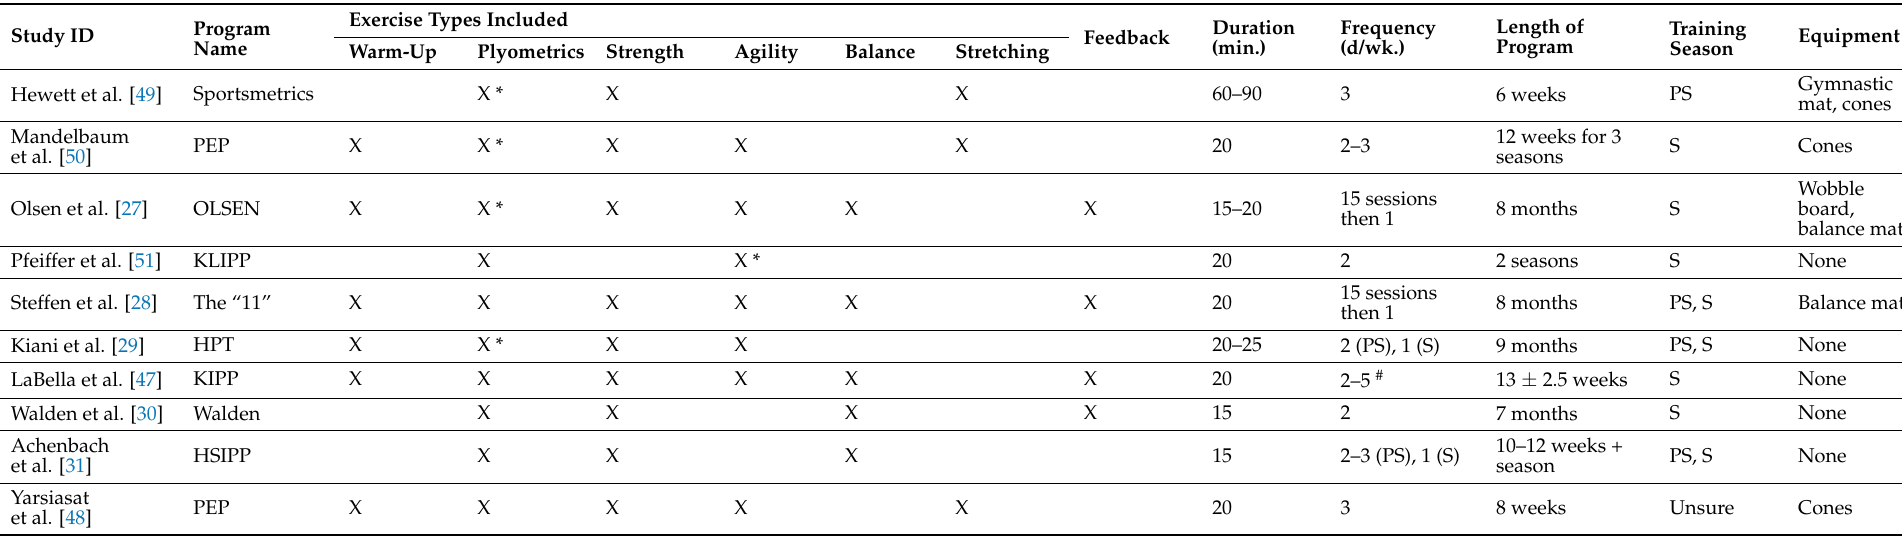
Table 5. Summary of intervention details for the primary